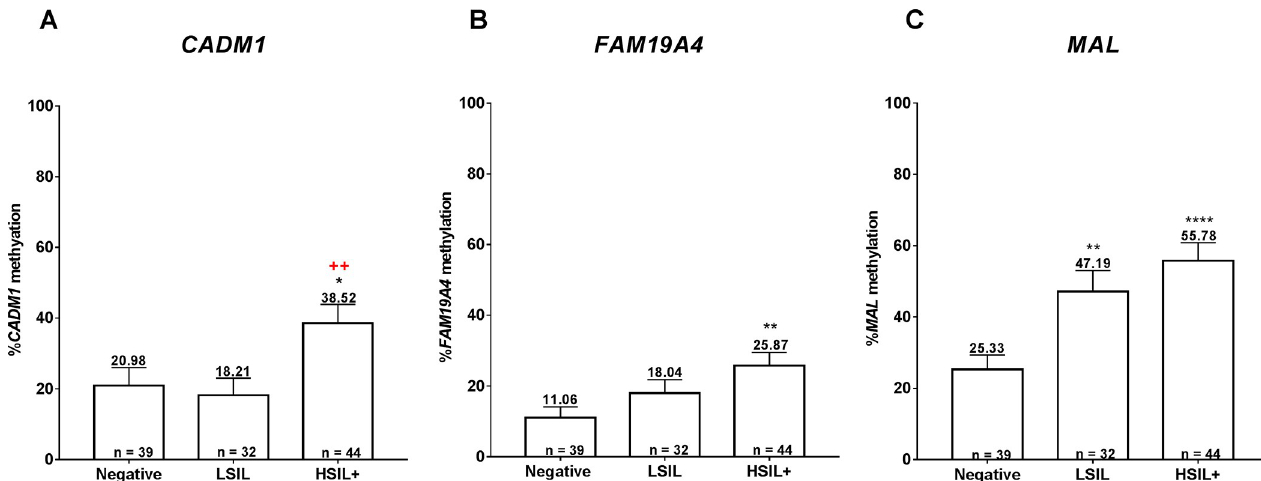
Fig 3. The methylation levels of three candidate genes; CADM1 (A), FAM19A4 (B), and MAL (C), in the different histologic grades (ANOVA with turkey’s multiple comparison post hoc test � p < 0.05, �� p < 0.01, ���� p < 0.0001 vs. negative and + p < 0.05 vs. histologic LSIL).